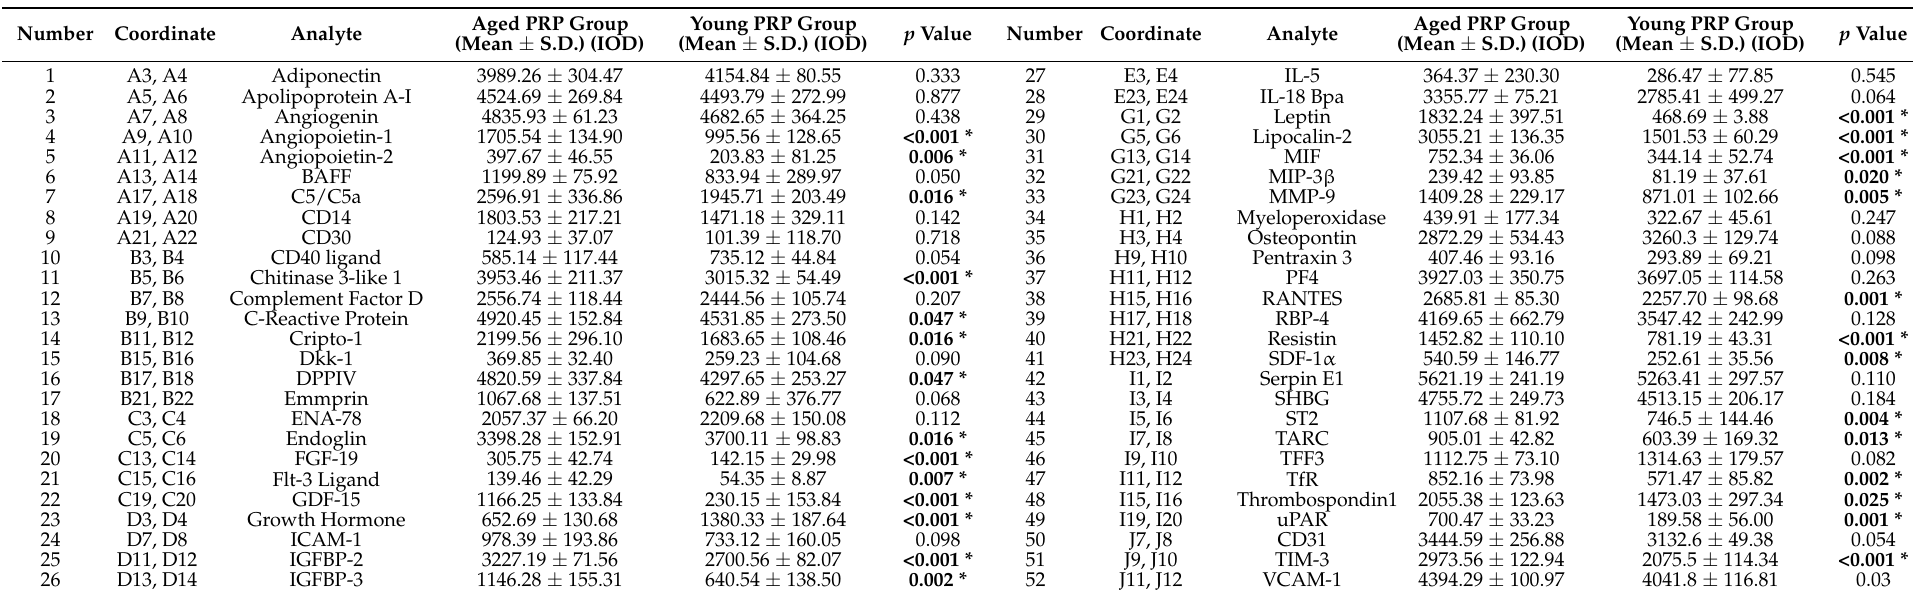
Table 4. Cytokine